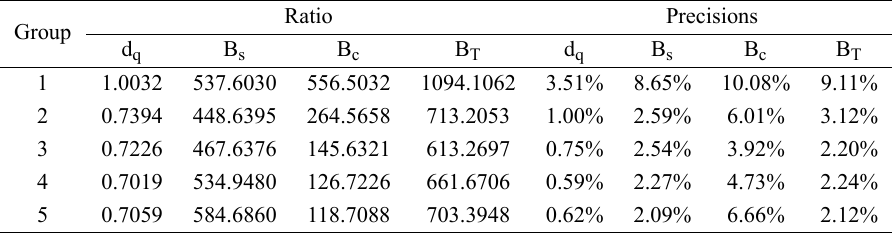
Coefficients and precisions obtained by means of procedure 2 to model the biomass of the components and total biomass as a function of the stem volume in stands of black wattle in the state of Rio Grande do Sul,